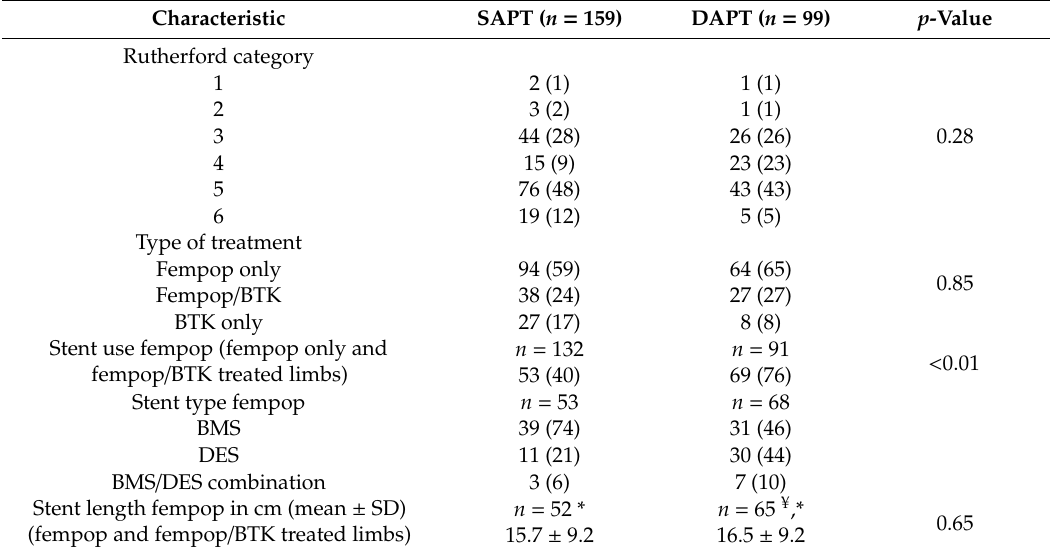
Table 3. Characteristics of the 258 treated